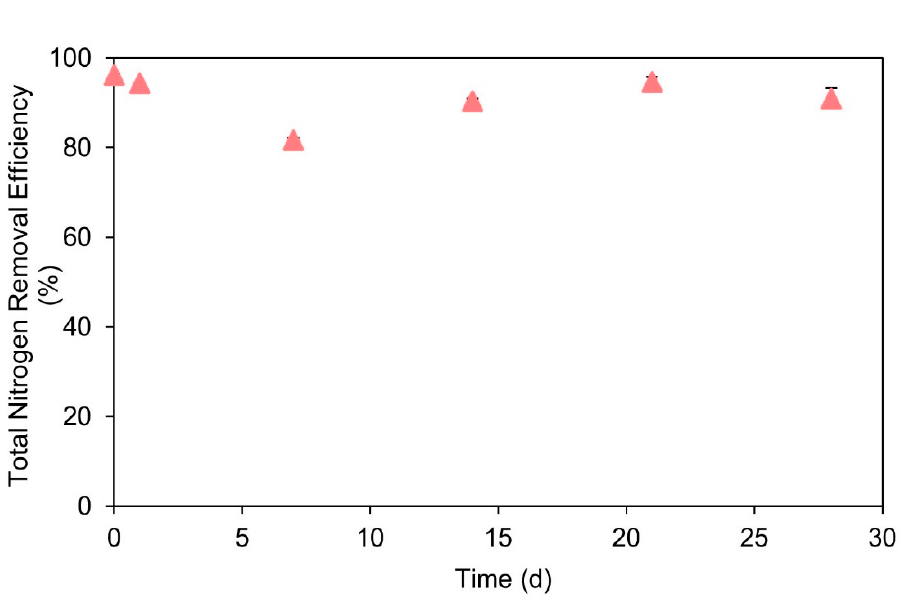
Figure 5. Specific anammox activity (SAA) of control and caffeine and inhibition (%) during the long-term caffeine dosing. 3.3. Treatment of Coffee Wastewater Using Anammox Process and the Recovery of Anammox Cultures after Discontinuance of Coffee Wastewater Additions The experimental control SBR was started with total nitrogen (TN) concentration (NH 4+ plus NO 2 − ) of 215 mg N/L. The nitrogen removal efficiency was found to be 82% with SAA at 0.867 mg-N/mg-VSS/d. Daily additions of coffee wastewater resulted in the accumulation of COD in the reactor. As indicated in Figure 6, COD in the treated effluent increased from 154 mg/L at day 1 to 508 mg/L at day 28. Meanwhile, the TN concentration increased from 286 mg N/L at day 1 to 391 mg N/L at the end of the 28 day experimental period.